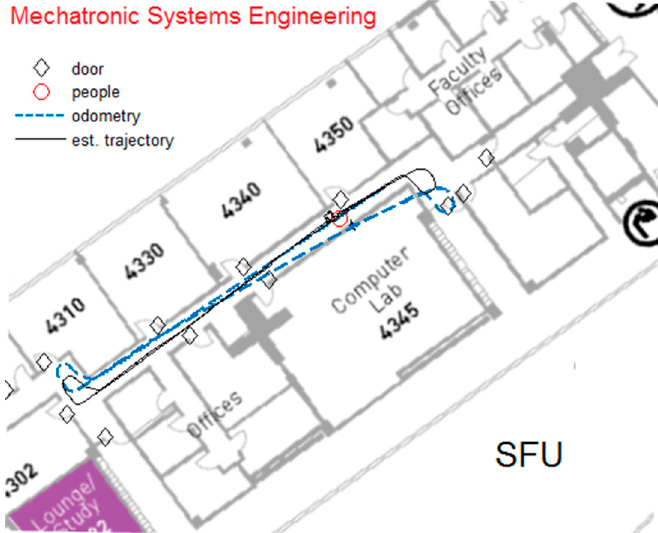
Figure 12. The estimated trajectory of the robot and the final estimated position of the doors in the